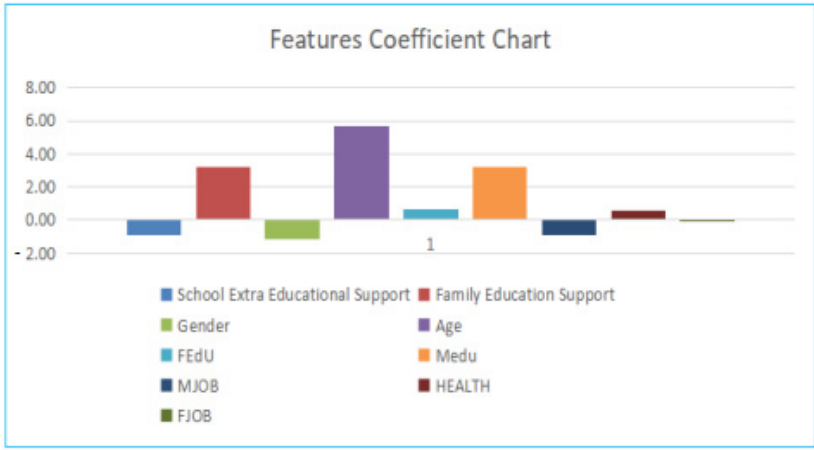
Figure 11. Coefficient of Features.